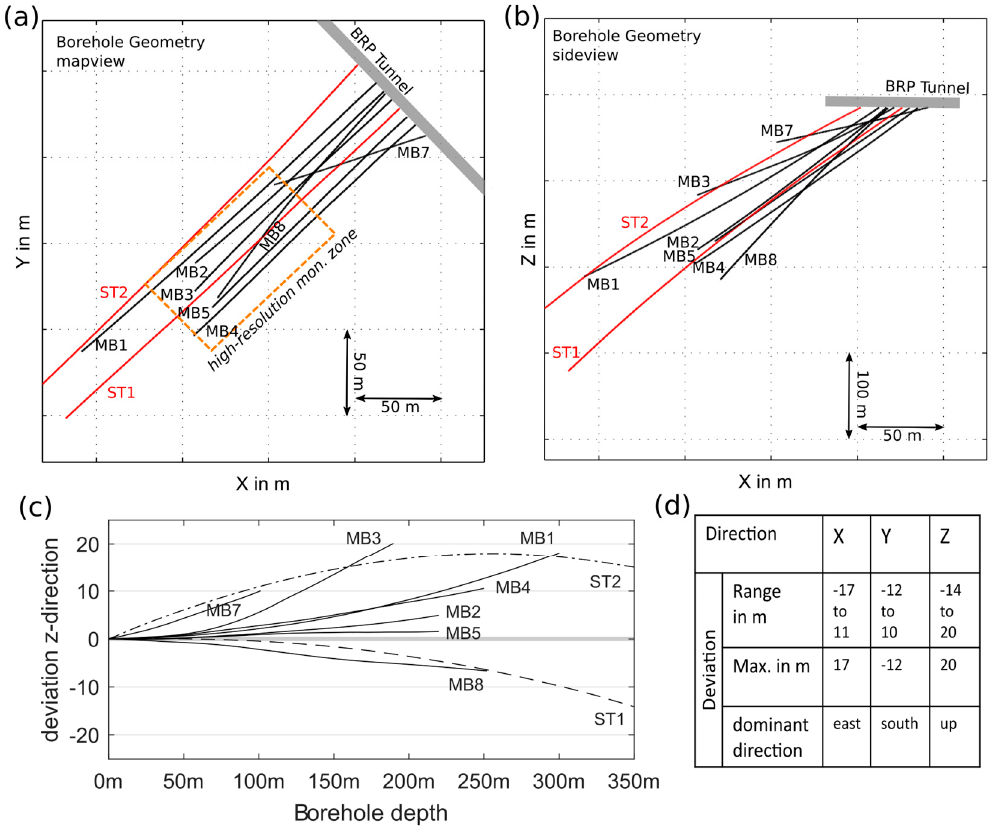
Figure 1. Boreholes of the Bedretto Reservoir Project (BRP) shown in ( a ) map view and ( b ) side view. Monitoring boreholes are shown as black lines; production boreholes are shown as red lines. In ( c ) the sum deviation between the straight boreholes trajectories planned and boreholes realized in the z-direction is shown. Most boreholes deviated upwards at distances >100 m from the borehole mouth. The maximum deviation is 20 m. Horizontal and vertical deviation is summarized in d).